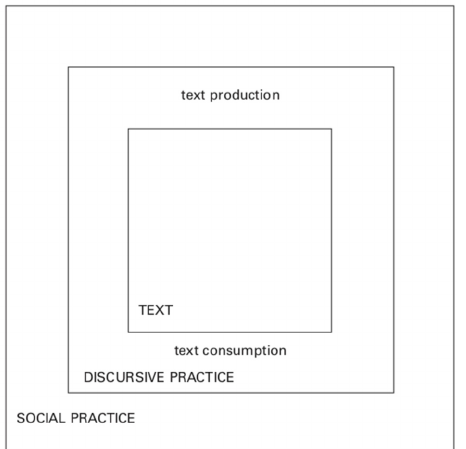
Figure 1. Fairclough’s three-dimensional model for critical discourse analysis.